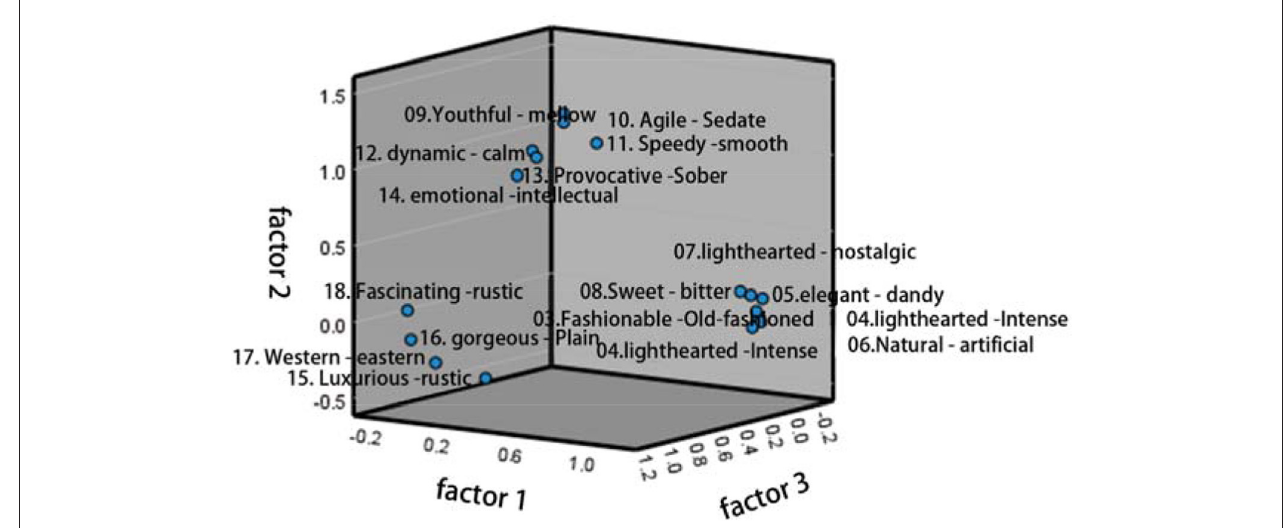
FIGURE 7 | Distribution of color semantics in the three-dimensional cognitive space.